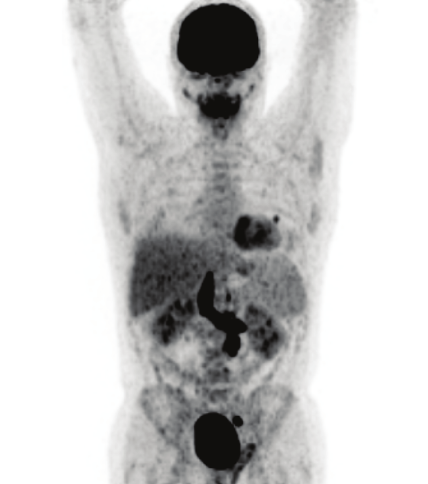
Figure 2: Fluorine-18 fluorodeoxyglucose (f-FDG) positron emis- sion tomography (PET) computerized tomography (CT) showing hypermetabolic IVC